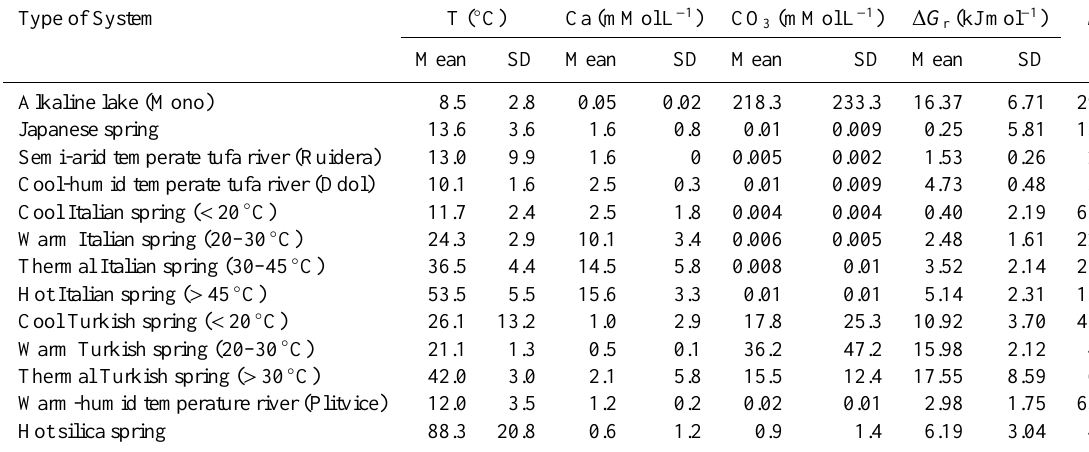
Table 2. Summary of field data (SD, standard